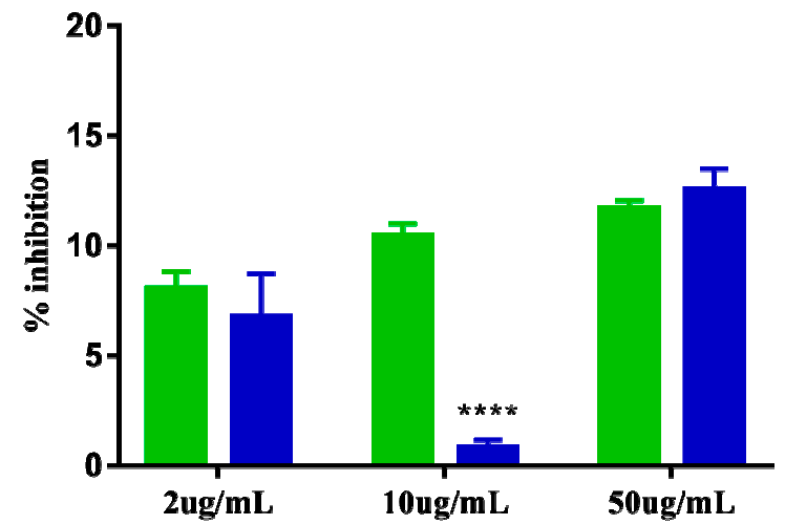
Figure 6. Percent inhibition of in vitro Cyclooxygenase-1 (COX-1) e Cyclooxygenase-2 (COX-2), induced by the crude extract of S. dulcis , tested in three concentrations: 2 µ g / mL, 10 µ g / mL, and 50 µ g / mL. The data are represented in mean + standard deviation of the means. **** Represents significant di ff erences, with p < 0.0001 comparing inhibition of COX-1 and